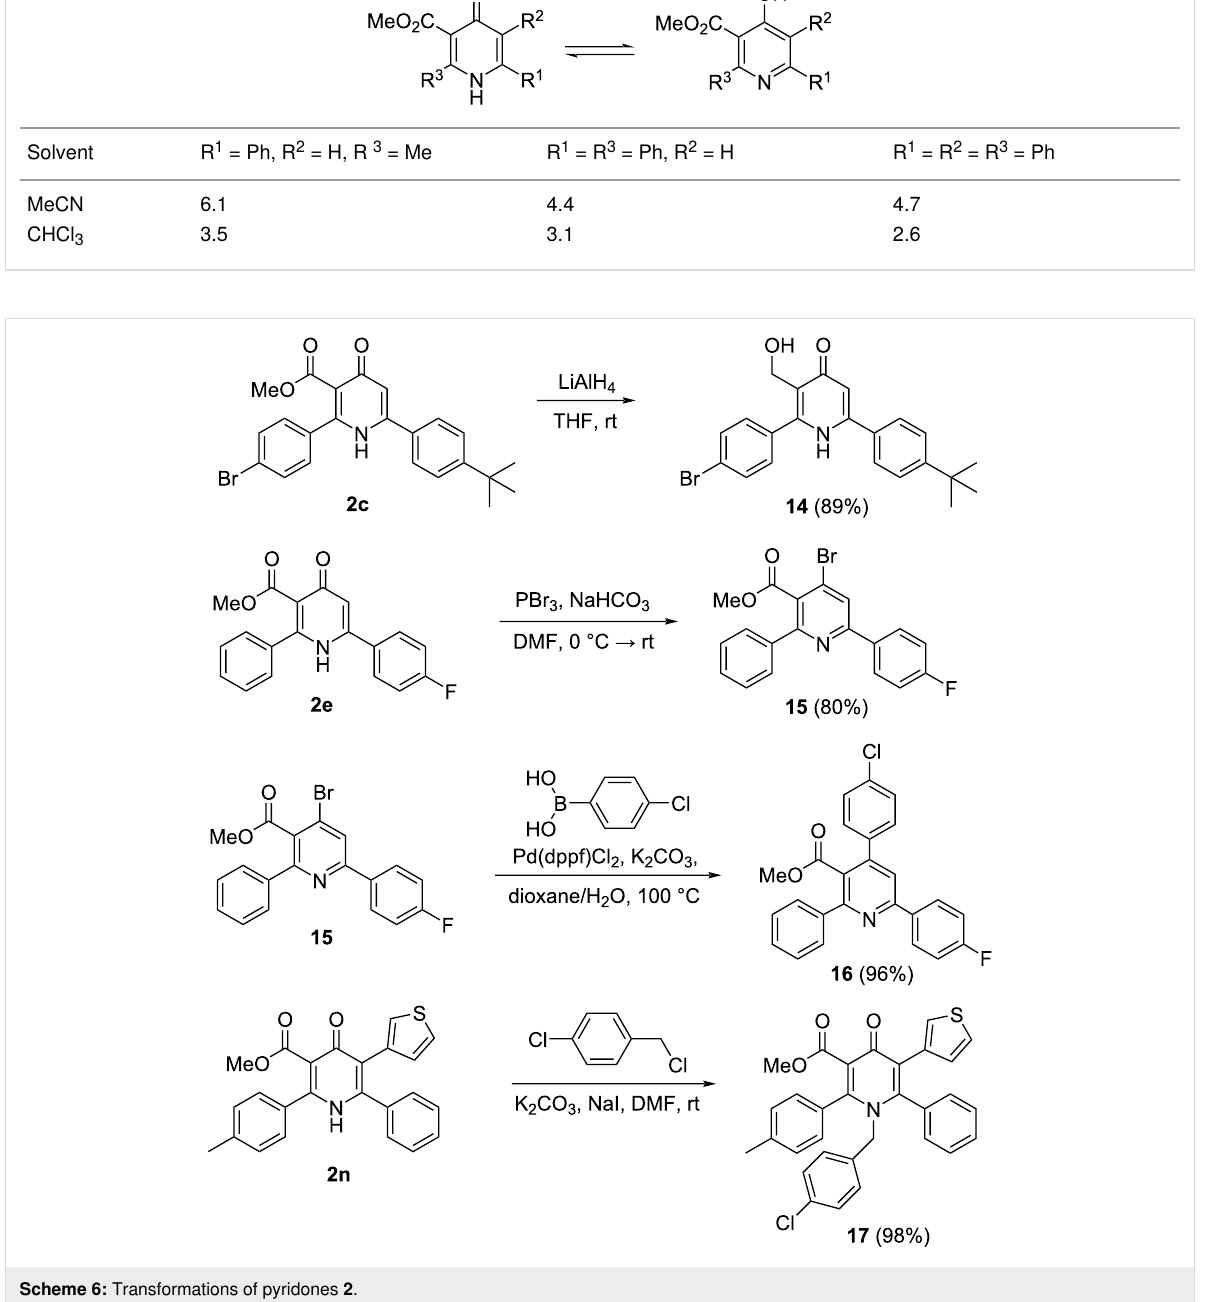
Table 1: Gibbs free energies of the pyridole tautomer relatively to the pyridone tautomer of compounds 2 (in kcal/mol, 298 K).